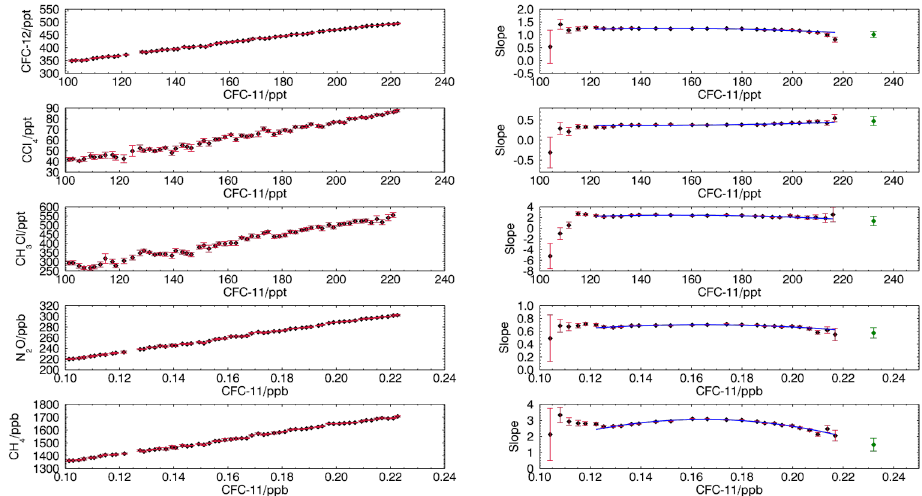
Figure B15 Correlations between the volume mixing ratios of CFC-12, CCl 4 , CH 4 , CH 3 Cl and N 2 O and CFC-11 for the data from the southern hemisphere during the stratospheric summer of 2010. Left panels: The mean correlation profile. Each point represents the mean of the VMR in a window of 2 ppt of CFC-11. The error on these points is the standard deviation of the data within each 2 ppt window. Right panels: The local slope of data in an 80 ppt of CFC-11 window. The error on the points is the fitting error of this fit. The blue line is a second degree polynomial fit to the local slopes. The green point is the extrapolated slope at the tropopause.